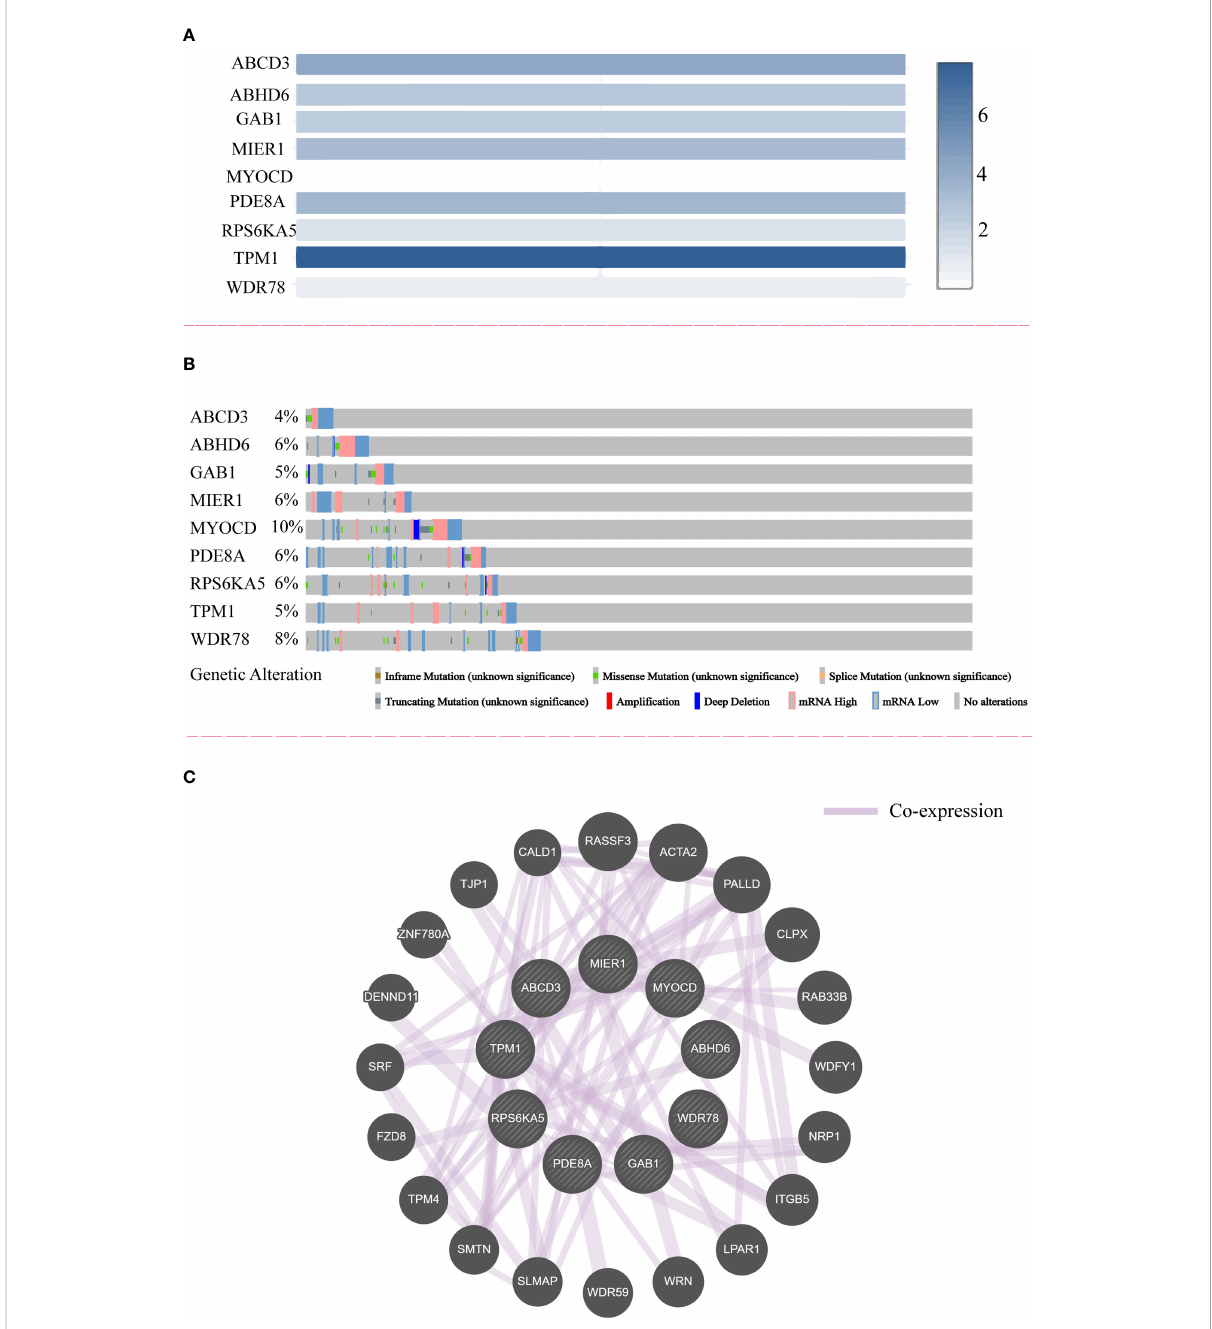
FIGURE 4 The relative expression, genetic alteration and co-expression of nine potential prognostic genes in CRC. (A) The relative expression of nine potential prognostic genes in CRC samples. (B) The genetic alteration of nine potential prognostic genes in CRC. (C) The co-expression network of nine potential prognostic